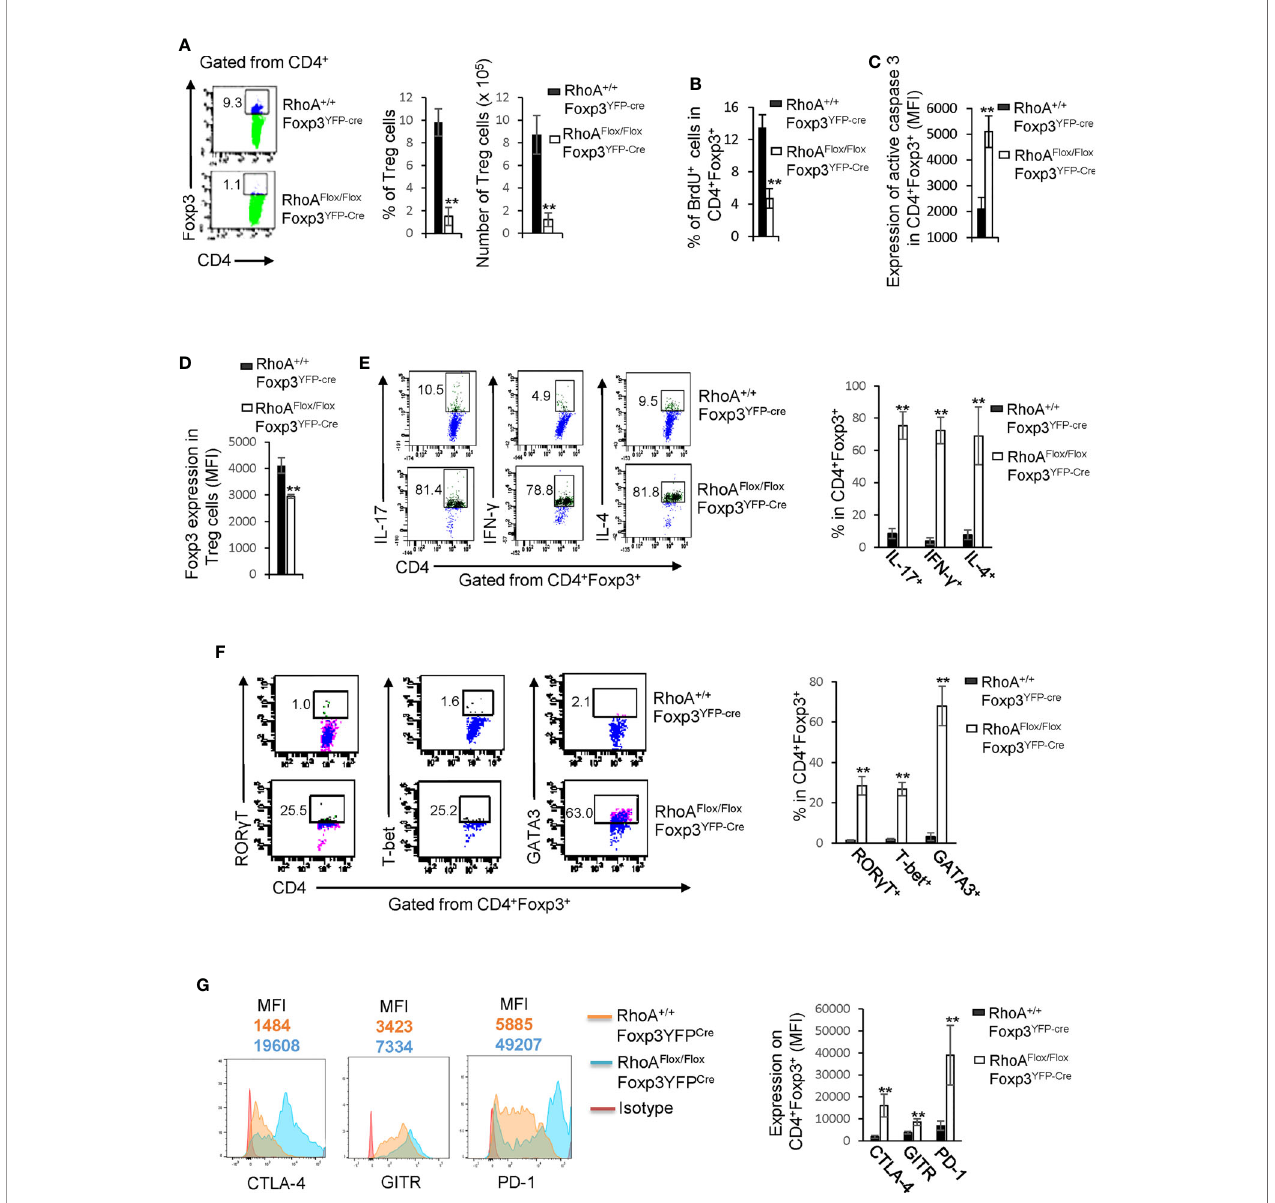
FIGURE 2 | Homozygous RhoA deletion in Treg cells dampens Treg cell homeostasis and induces Treg cell plasticity. (A) Left, representative fl ow cytogram of Foxp3 staining in CD4 + cells from the spleen of RhoA +/+ Foxp3 YFP-Cre and RhoA Flox/Flox Foxp3 YFP-Cre mice. The numbers indicate percentages of CD4 + Foxp3 + Treg cells. Middle, average percentages of CD4 + Foxp3 + Treg cells. Right, average numbers of CD4 + Foxp3 + Treg cells. (B) Treg cell proliferation. Percentages of CD4 + Foxp3 + Treg cells incorporated with BrdU are shown. (C) Treg cell apoptosis. The expression levels (MFI: Mean fl uorescence intensity) of active caspase 3 in CD4 + Foxp3 + Treg cells are shown. (D) The expression levels of Foxp3 in Treg cells. (E) Left, representative fl ow cytogram of IL-17, IFN- g , and IL-4 staining in CD4 + Foxp3 + Treg cells. The numbers indicate percentages of IL-17 + , IFN- g + , and IL-4 + Treg cells. Right, average percentages of IL-17 + , IFN- g + , and IL-4 + Treg cells. (F) Left, representative fl ow cytogram of ROR g T, T-bet and GATA3 staining in CD4 + Foxp3 + Treg cells. The numbers indicate percentages of ROR g T + , T-bet + , and GATA3 + Treg cells. Right, average percentages of ROR g T + , T-bet + , and GATA3 + Treg cells. (G) Left, representative histogram of the expression levels of CTLA-4, GITR and PD-1 in CD4 + Foxp3 + Treg cells. The numbers above the graphs indicate MFI. Right, average MFI of CTLA-4, GITR and PD-1 in CD4 + Foxp3 + Treg cells. n = 3 mice. Data are representative of two independent experiments. Error bars indicate SD. **p <